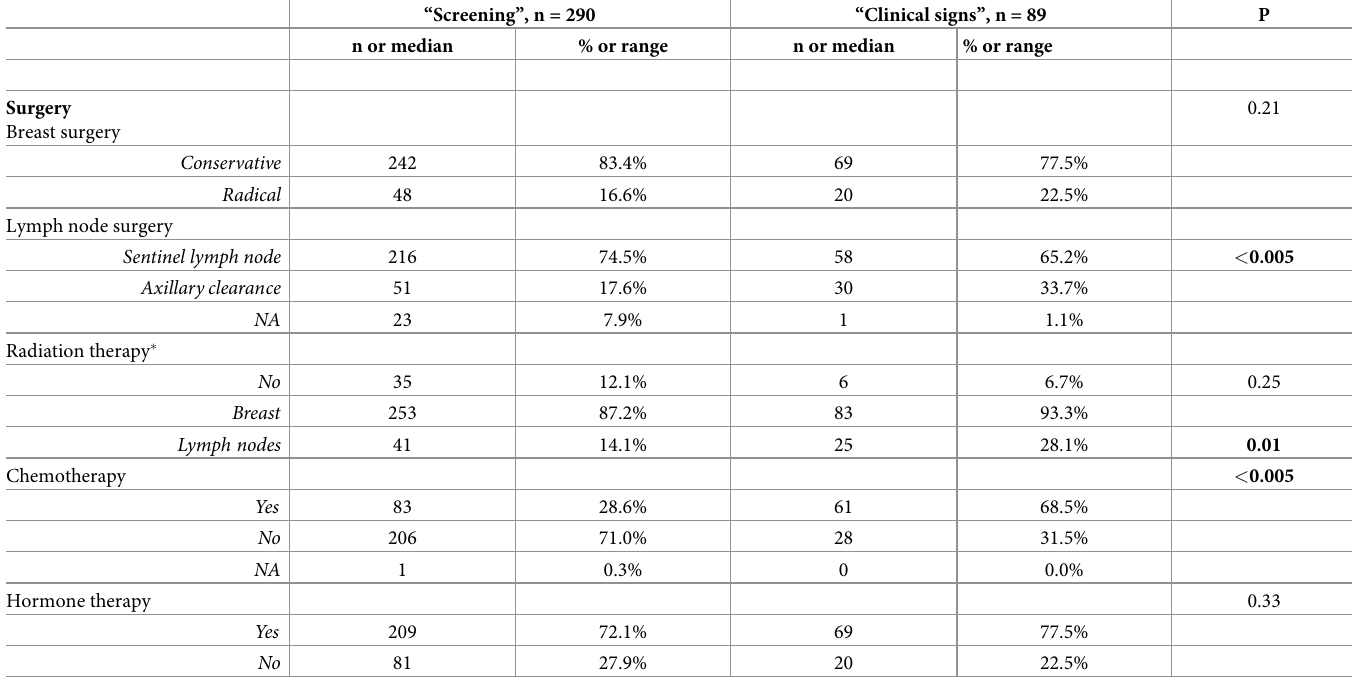
Table 1. Locoregional and systemic management in the “Screening” group and “Clinical signs” group. “Screening”, n = 290 “Clinical signs”, n =